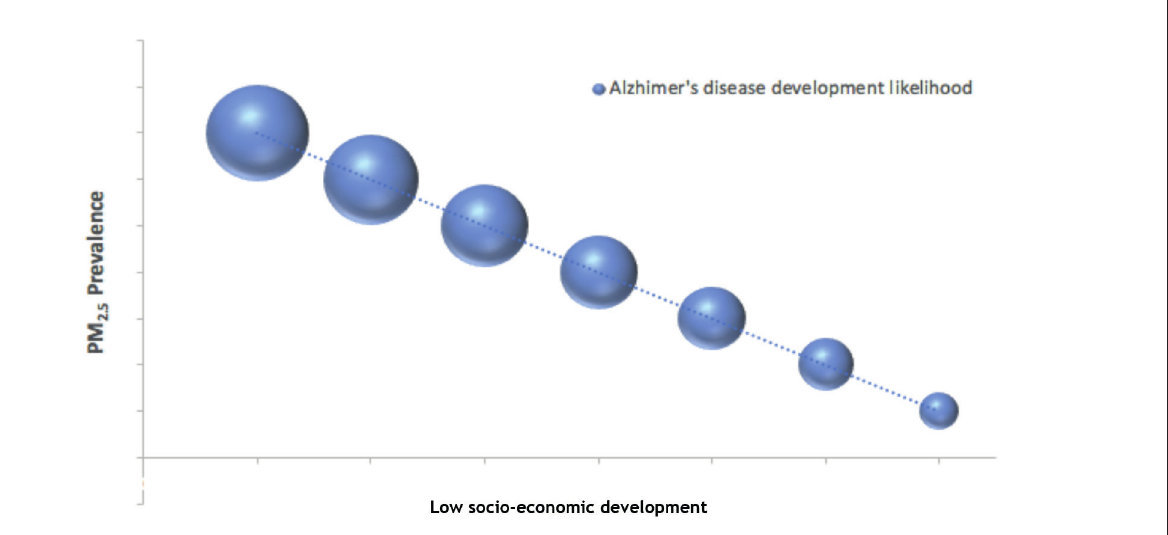
Figure 8. An integrated, multi-level model of the interactions between air pollution, socio-economic development, and Alzheimer’s